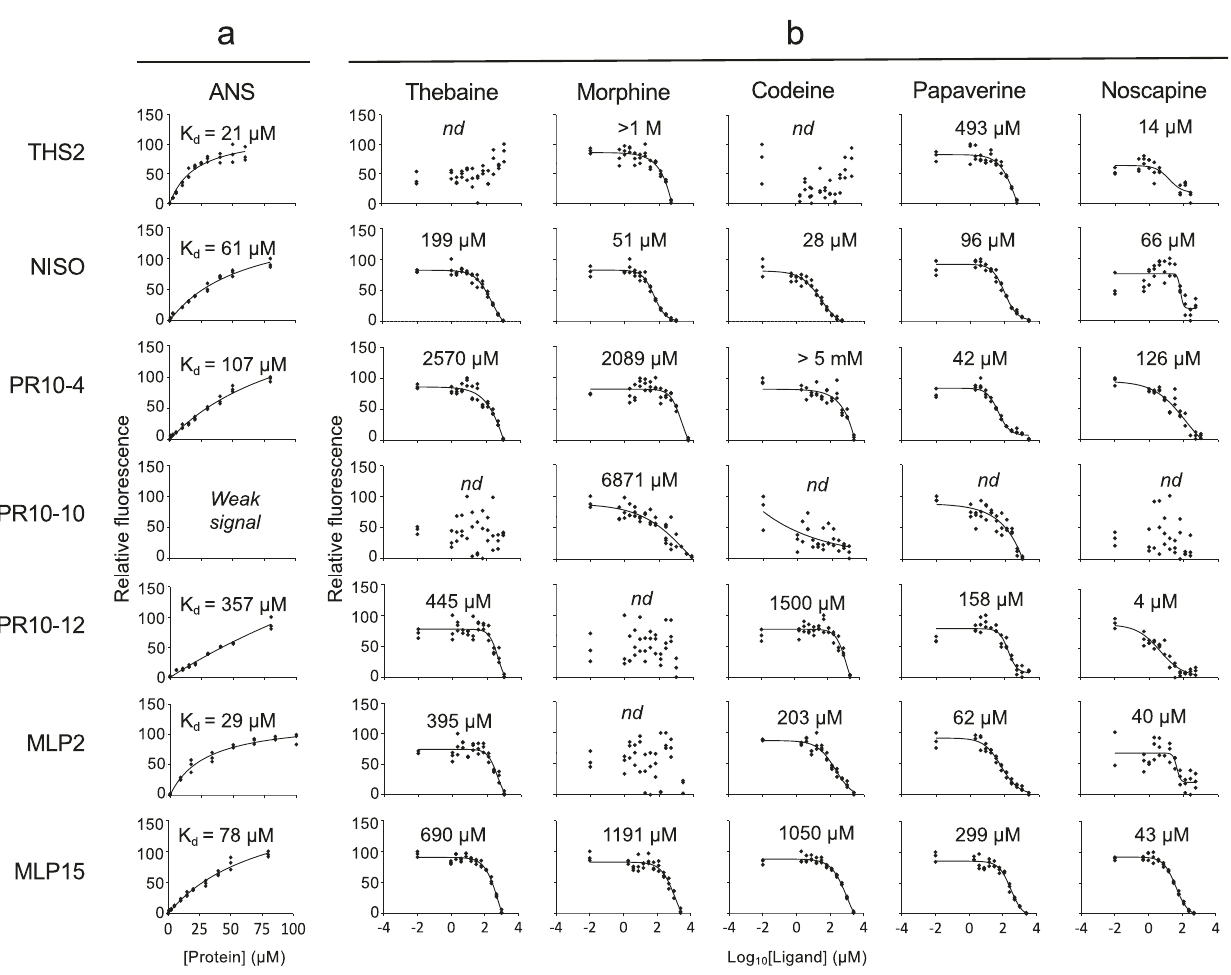
Fig. 3 | Relative ANS fl uorescence, displacement curves and calculated IC 50 values for the most abundant MLP/PR10 proteins and the major alkaloids in opium poppy latex. a Af fi nity between ANS and each MLP/PR10 protein was determined directly based on fl uorescence and the corresponding K d value was calculated. ANS concentration (10 µ M) was fi xed and MLP/PR10 protein con- centration was varied from 0 to 100 µ M. A one-site hyperbolic model was fi t to determine K d values. b BIA binding-induced decrease in fl uorescence caused by